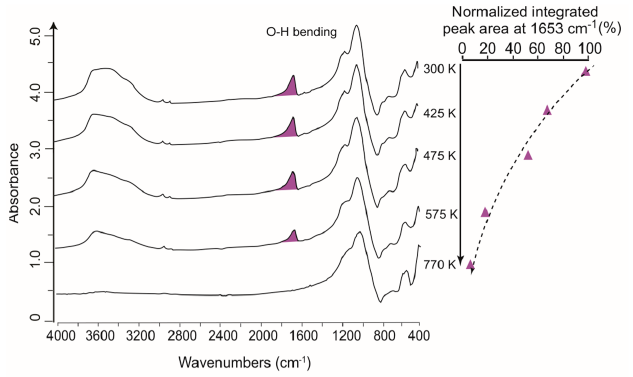
Figure 9. Left : Micro-IR spectra of stilbite collected at different temperatures (300, 425, 475, 575 and 770 K) in the 4000–400 cm − 1 wavenumber range. Modified after figure 2 in Prasad et al. [134] with copyright permission from Mineralogical Society of America; Right : absorbance of H 2 O (represented by O–H bending, purple-filled area) with increasing temperature from 425 to 770 K normalized to that at 300 K. The normalized H 2 O absorbances were derived from corresponding FTIR spectra on the left and show dehydration with increasing